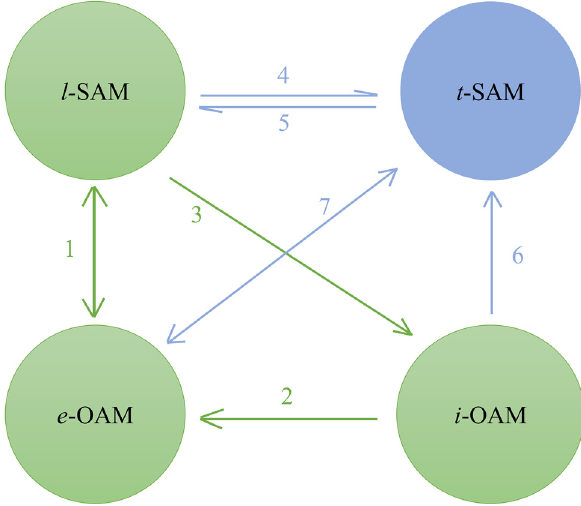
Figure 1: Various intriguing optical effects resulted from the interplay and mutual conversions between different types of AMs.